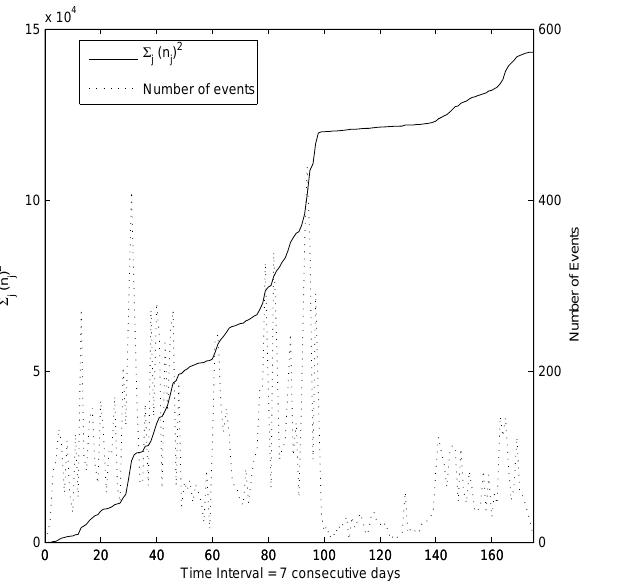
Fig. 8. Plot of Eq. (4) for Macassa mine (solid line) and the number of events recorded per time bin t (dashed